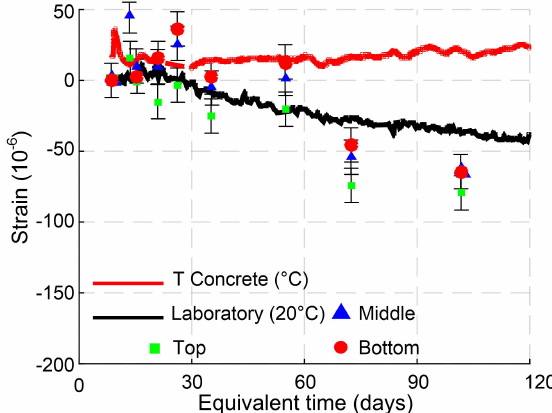
Figure 17. Temperature (solid red line), average strain over four frames of structural concrete at the top, middle and bottom levels of the frames (average value of extensometers located on the supporting frames 1, 2, 4 and 5) and strain at the material scale from laboratory measurement (solid black